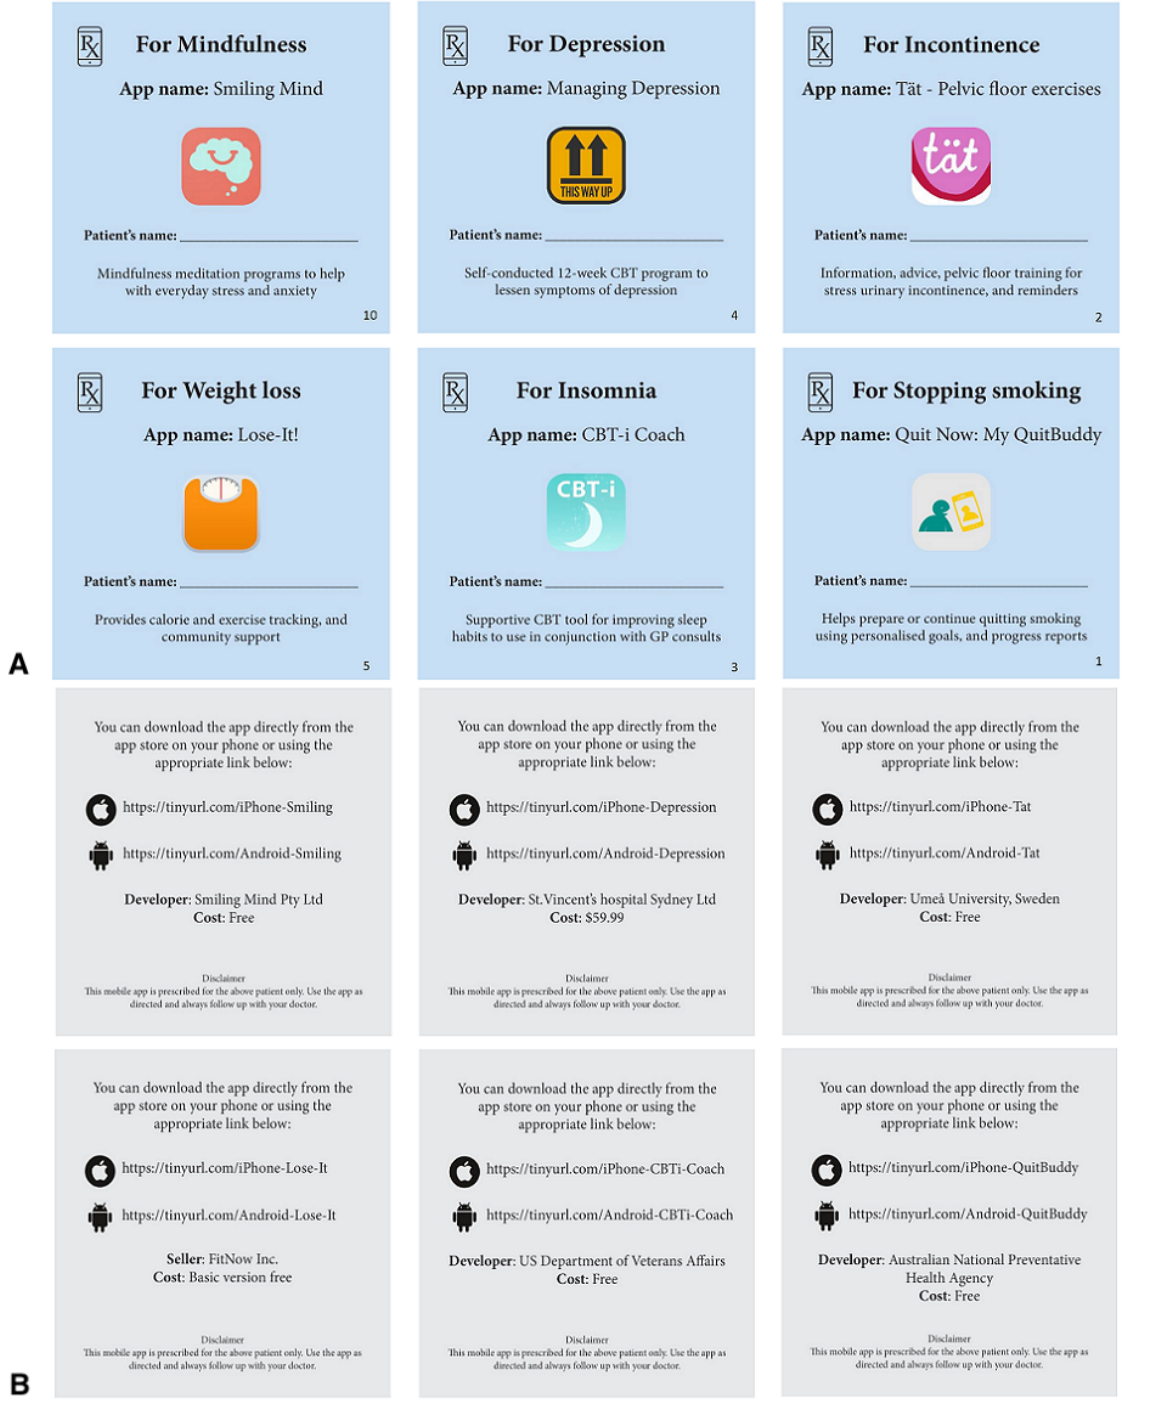
Figure 1. The 6 app prescription pads, showing the front (A), with prescription details and script number in the bottom right corner, and back (B), with app download instructions and